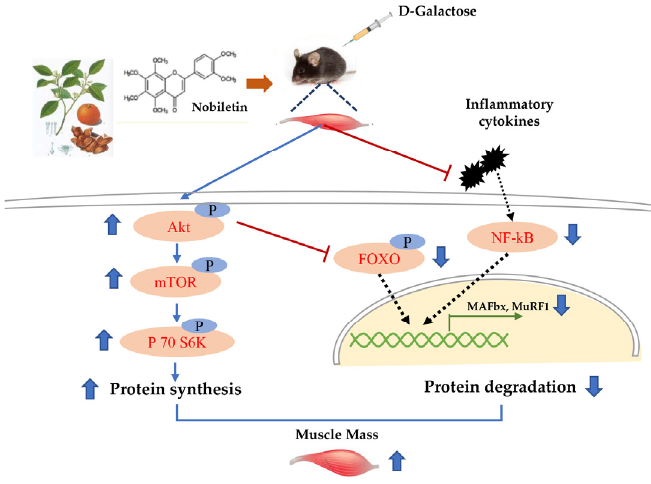
Figure 6. Schematic diagram of Nob-mediated prevention of skeletal muscle atrophy. Protein kinase B (AKT); Rapamycin (mTOR); Ribosomal protein S6 kinase beta-1 (S6K1), also called P 70 S6 kinase (P 70 S6K), Nuclear factor-kappa B (NF- κ B), Foxhead box O3 (FOXO3), Muscle atrophy F-box (MAFbx), Muscle RING Finger 1 (MuRF1).